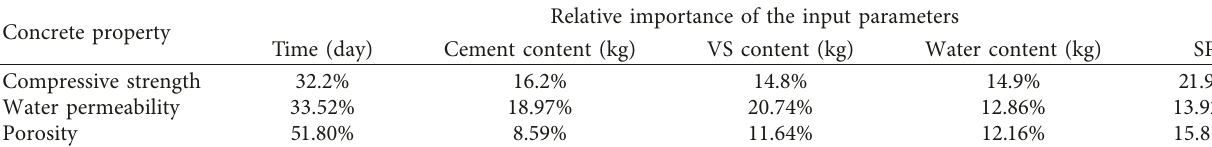
Table 6: The relative importance of input